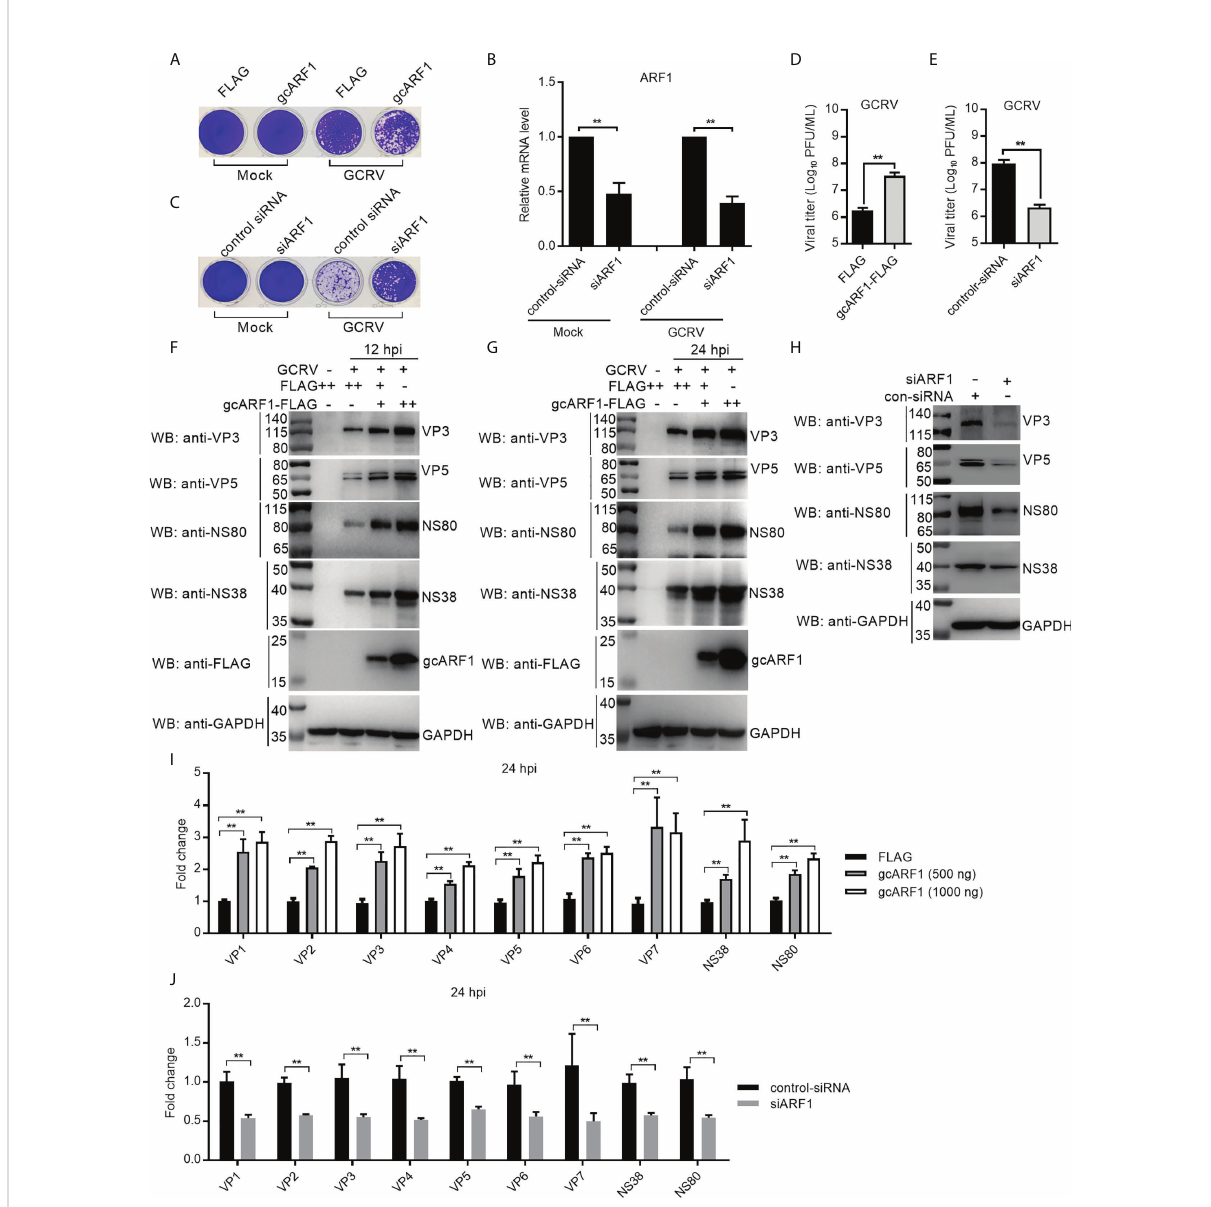
FIGURE 1 gcARF1 promotes GCRV infection. (A) Crystal violet staining for overexpression of gcARF1 in CIK cells that were mock infected or infected with GCRV at an MOI of 1 for 24 h. (B) The effect of knockdown of gcARF1 on the expression of gcARF1 in CIK cells that were mock infected or infected with GCRV at an MOI of 1 for 24 h. (C) Crystal violet staining for knockdown of gcARF1 in CIK cells that were mock infected or infected with GCRV at an MOI of 1 for 24 h. (D, E) Virus yield for overexpression and knockdown of gcARF1 in CIK cells infected with GCRV at an MOI of 1 for 24 h. (F, G) IB analysis of VP3, VP5, NS80 and NS38 proteins regulated by overexpression of gcARF1 in CIK cells infected with GCRV. CIK cells seeded overnight in 6-well plates were transiently transfected with FLAG vector or gcARF1-FLAG (+: 500 ng, ++: 1000 ng). 24 h later, the cells were infected with the GCRV at an MOI of 1 or left untreated. The cells were collected at 12 (F) or 24 dpi (G) for protein extraction. (H) IB analysis of VP3, VP5, NS80 and NS38 proteins regulated by knockdown of gcARF1 in CIK cells infected with GCRV for 24 h. CIK cells seeded overnight in 6-well plates were transiently transfected with 100 nM control-siRNA or siARF1. After 24 h later, the cells were infected with the GCRV at an MOI of 1 or left untreated. The cells were collected at 24 hpi for protein extraction. (I) qRT-PCR analysis of VP1 , VP2 , VP3 , VP4 , VP5 , VP6 , VP7 , NS38 or NS80 expression regulated by overexpression of gcARF1 in CIK cells infected with GCRV. CIK cells seeded overnight in 6-well plates were transiently transfected with FLAG vector or gcARF1-FLAG. After 24 h later, the cells were infected with the GCRV at an MOI of 1. Another 24 h later, these cells were collected and used for RNA extraction and qRT-PCR. (J) qRT-PCR analysis of VP1 , VP2 , VP3 , VP4 , VP5 , VP6 , VP7 , NS38 or NS80 expression regulated by knockdown of gcARF1 in CIK cells infected with GCRV for 24 h. CIK cells seeded overnight in 6- well plates were transiently transfected with 100 nM control-siRNA or siARF1. After 24 h later, the cells were infected with the GCRV at an MOI of 1. Another 24 h later, these cells were collected and used for RNA extraction and qRT-PCR. Means ± SEM (n=3) are shown in (B, D, E, I, J) . Data were tested for statistical signi fi cance, ** p <